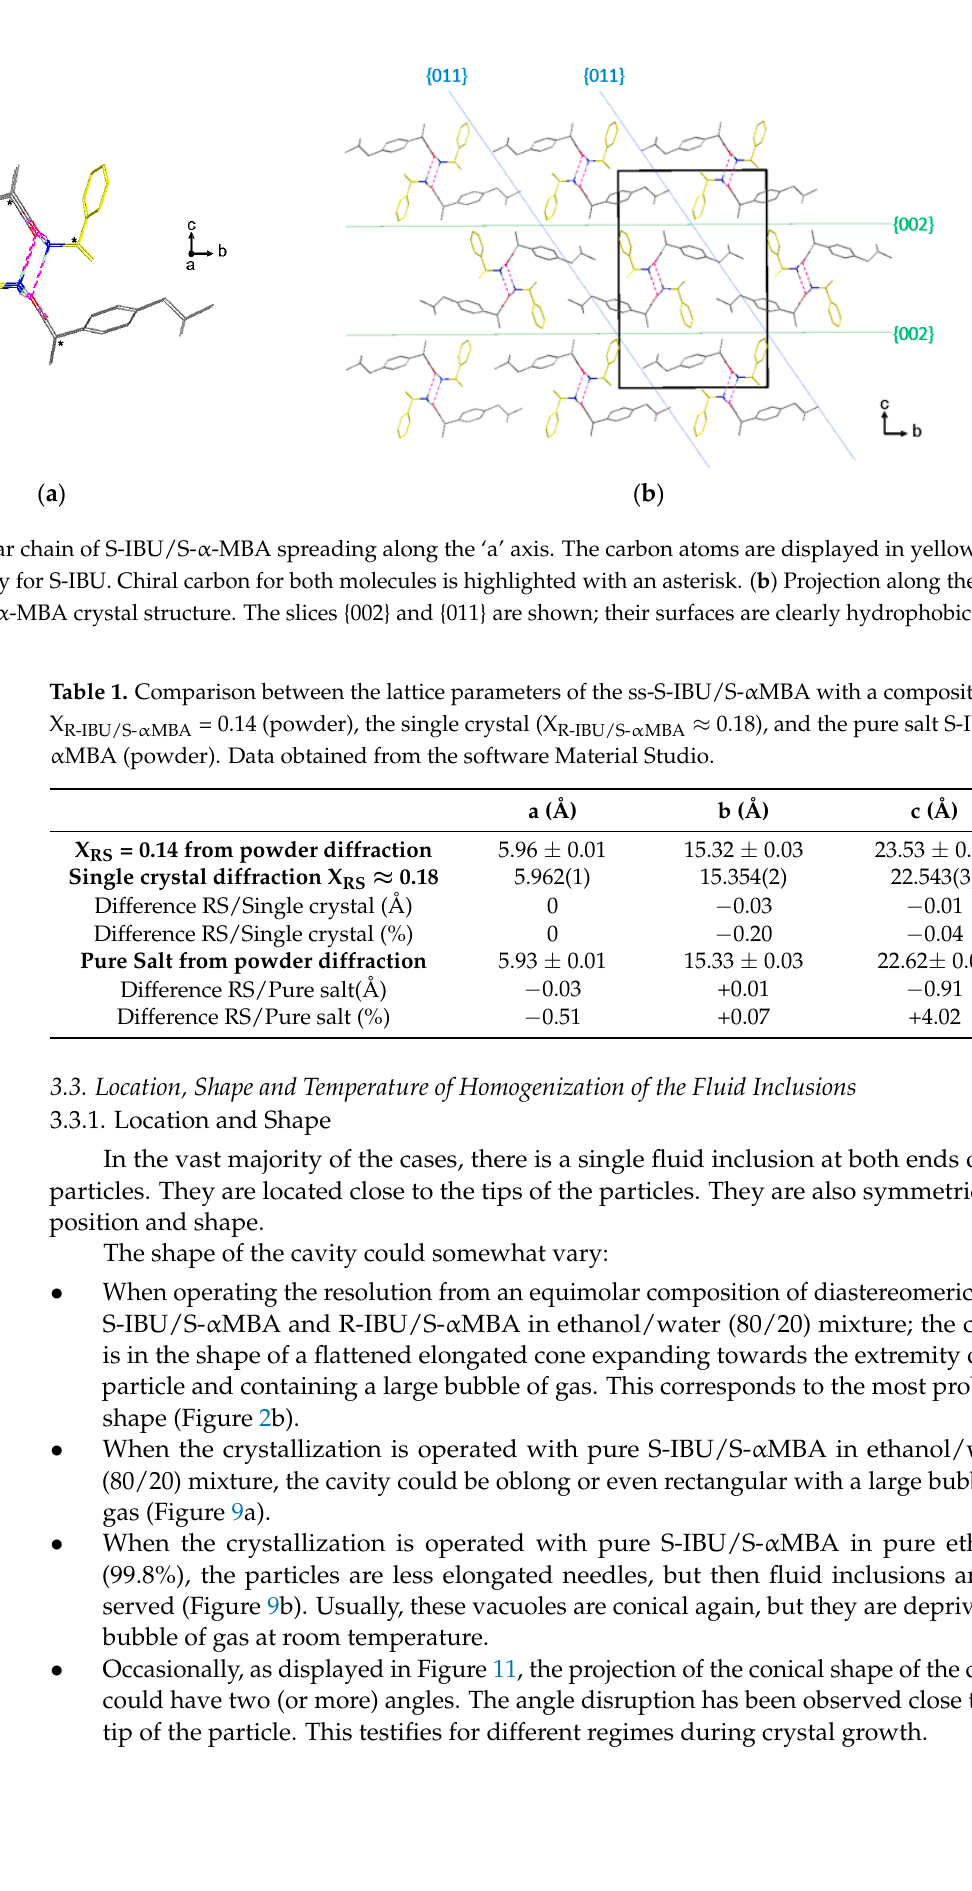
Figure 9. Snapshots obtained by means of polarized light microscopy. ( a ) Particle obtained by cooling from 40 °C to 20 °C of pure S-IBU/S- α MBA in ethanol/water (80/20) mixture; the particle exhibits two colors with a clear dividing line, sug- gesting that it results in an association of two different crystals. ( b ) Particle obtained by cooling from 40 °C to 20 °C of pure S-IBU/S- α MBA in pure ethanol (99.8%).